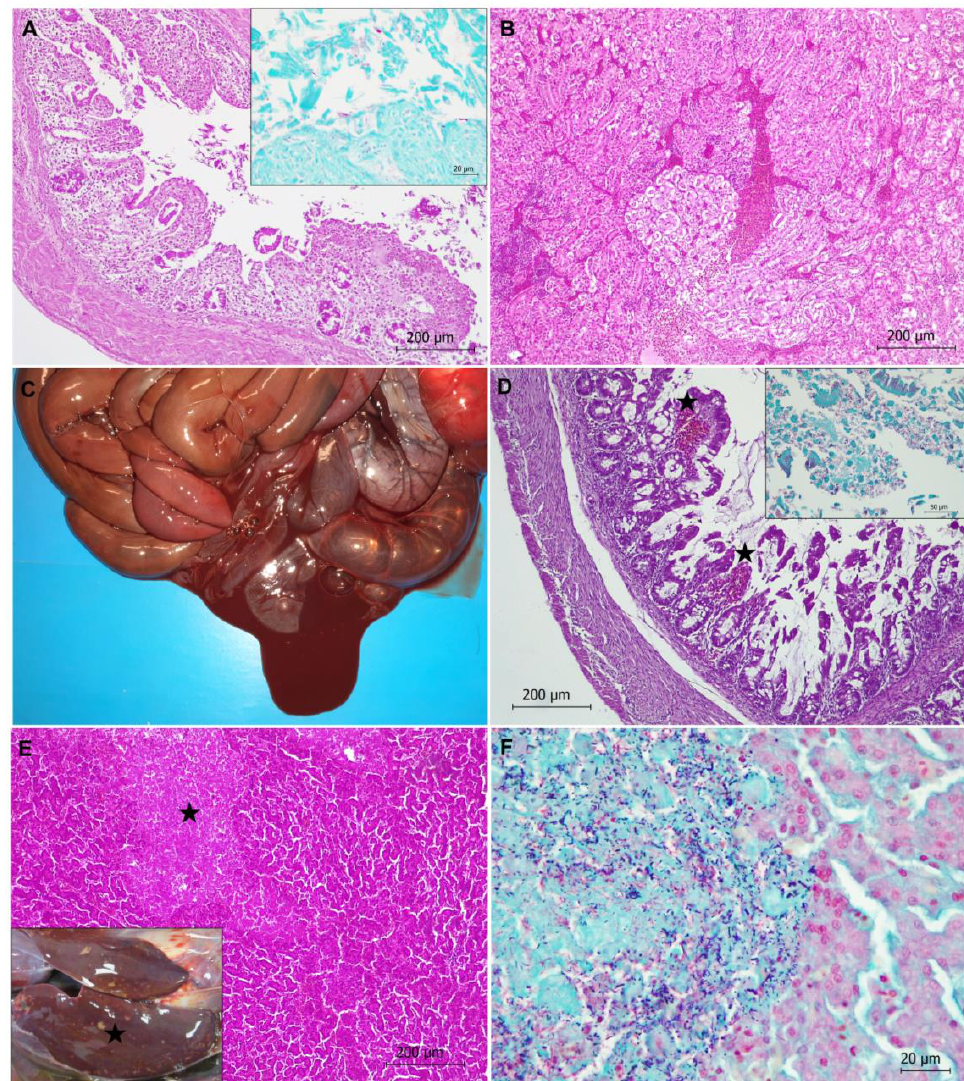
Figure 2. Colibacillosis ( A , B ) and clostridiosis ( C – F ) in Cantabrian capercaillies. ( A ) Typhlitis due to Escherichia coli infection is observed, characterized by epithelial cell damage of the mucosa and inflammatory infiltrate. Hematoxylin-eosin stain. Inset: Gram-negative bacilli compatible with E. coli are present on the apical surfaces of mucosal epithelial cells. Gram stain. ( B ) Congestion and hemorrhage in kidney of an animal with colibacillosis. Hematoxylin-eosin stain. ( C ) Hemorrhagic enteritis is observed in a capercaillie with Clostridium perfringens infection. ( D ) Histological features in the intestine of a capercaillie with clostridiosis. Necrotic typhlitis is observed; stars indicate hemorrhages. Destruction of intestinal mucosa and network of fibrin are also detected. Hematoxylin- eosin stain. Inset: Presence of numerous Gram-positive bacilli adhered to the mucosal epithelium are shown. Gram stain. ( E ) Necrotic hepatitis with a focus of necrosis (star) in the liver parenchyma is observed. Hematoxylin-eosin stain. Inset: Multiple whitish-yellowish foci of necrosis (star) are observed in the liver. ( F ) Numerous Gram-positive bacilli compatible with Clostridium spp. are located in the focus of necrosis observed in ( E ). Gram